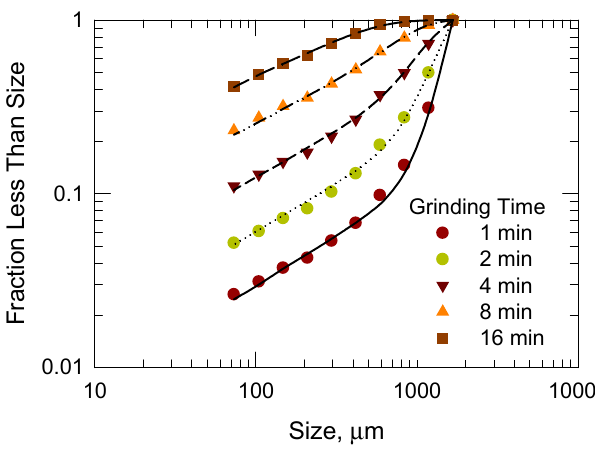
Figure 6. Experimental and simulation product size distributions for various batch grinding times (solid lines indicate the simulation results) for ( O ) .